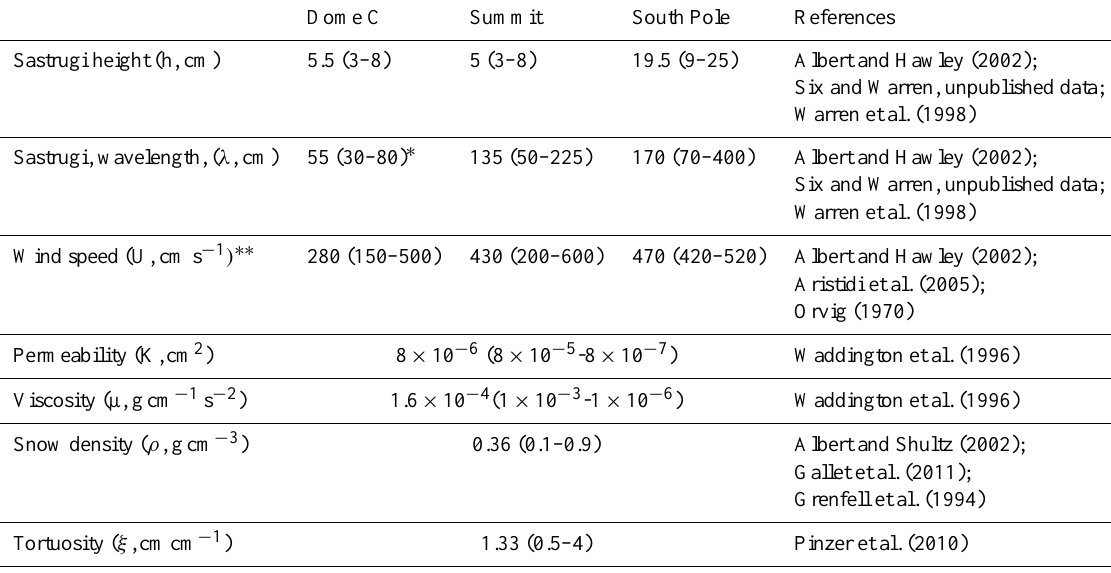
Table 3. Values for the variables used to calculate the lifetime of NO x in the snowpack interstitial air against escape to the overlying atmosphere via wind pumping during austral summer at Dome C and South Pole and during summer at Summit. The base-case values are provided along with the full range of values used in the sensitivity studies in